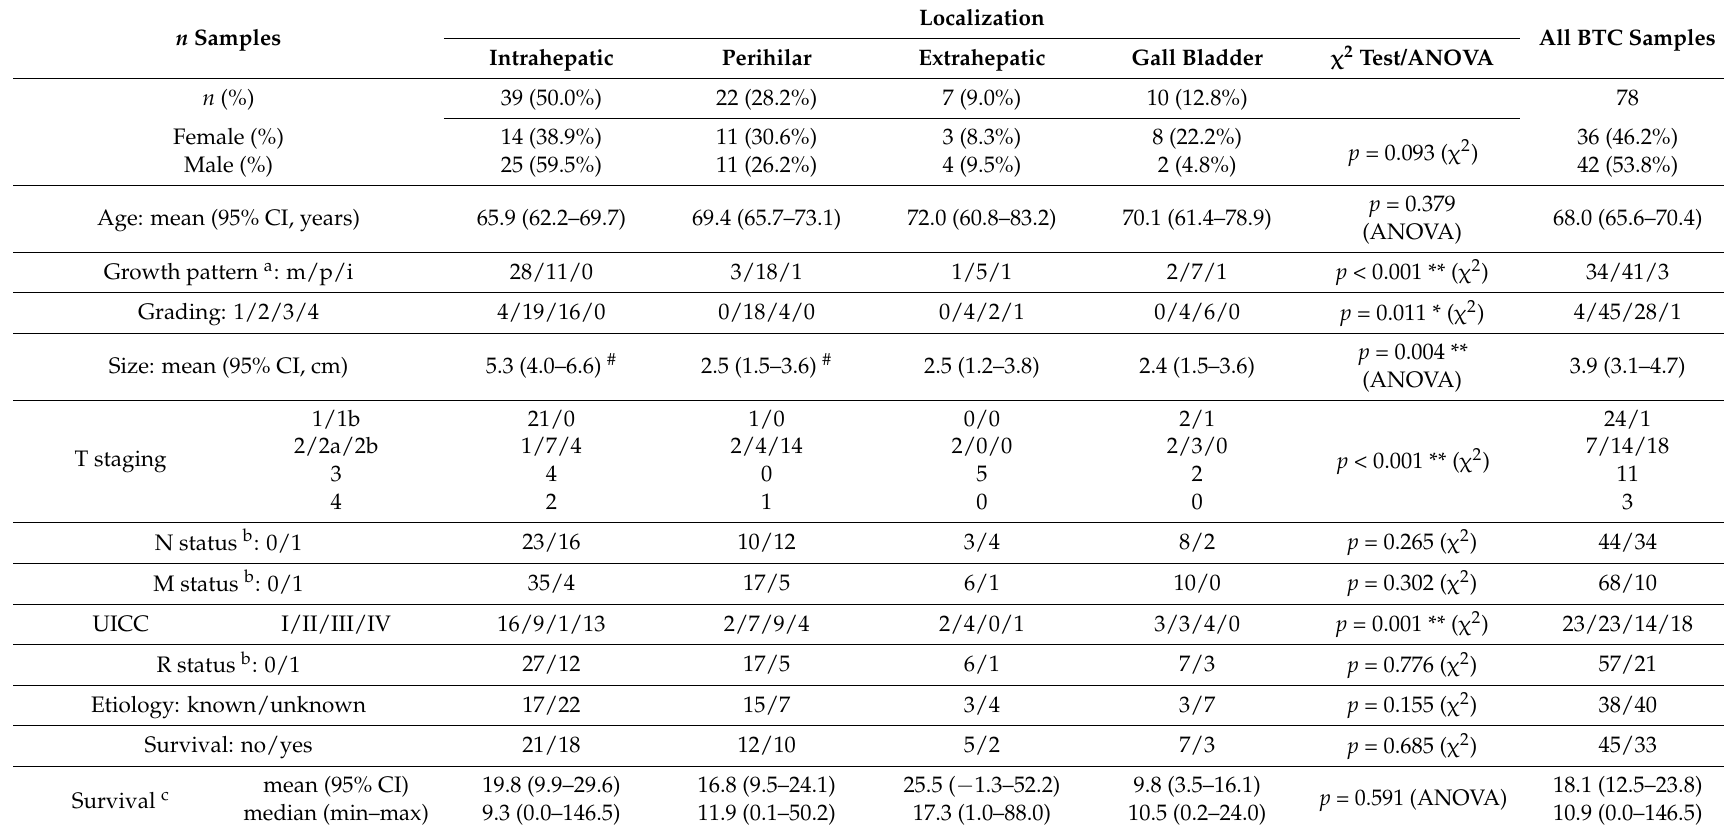
Table 1. Clinical and pathological characteristics of biliary tract cancer (BTC)